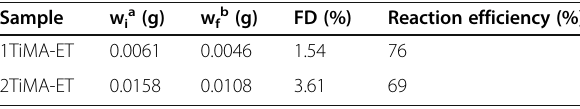
Table 1 Functionalization degree and reaction efficiency of the samples 1TiMA-ET and 2TiMA-ET Sample